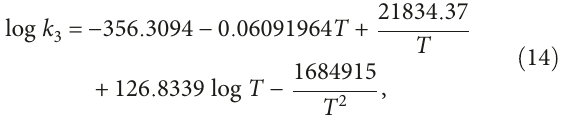
Figure 10: Variation in the Ca 2+ concentration over time. The dotted line data refers to the ICP instrument being rebooted due to the replacement of the instrument operation gas.